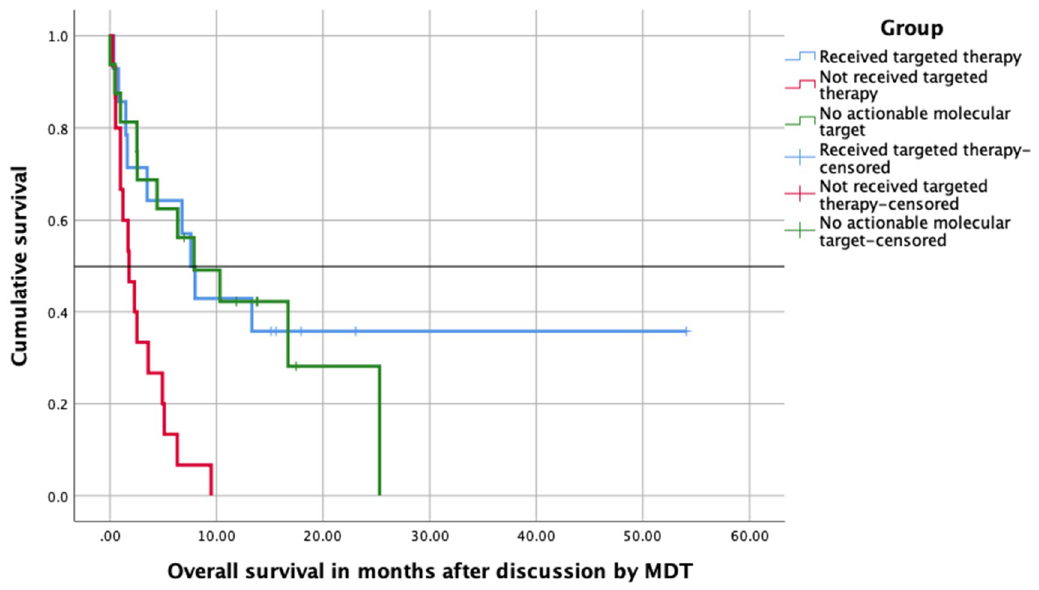
Figure 2. Kaplan–Meier curves showing overall survival after discussion by the multidisciplinary team (MDT) in three different R/M patient groups.